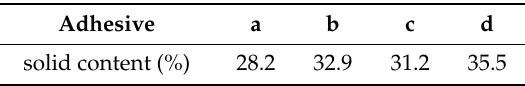
Table 2. The solid content of the adhesives: ( a ) SF adhesive; ( b ) SF/LB adhesive; ( c ) SF/PAE adhesive; and ( d ) SF/LB/PAE adhesive.